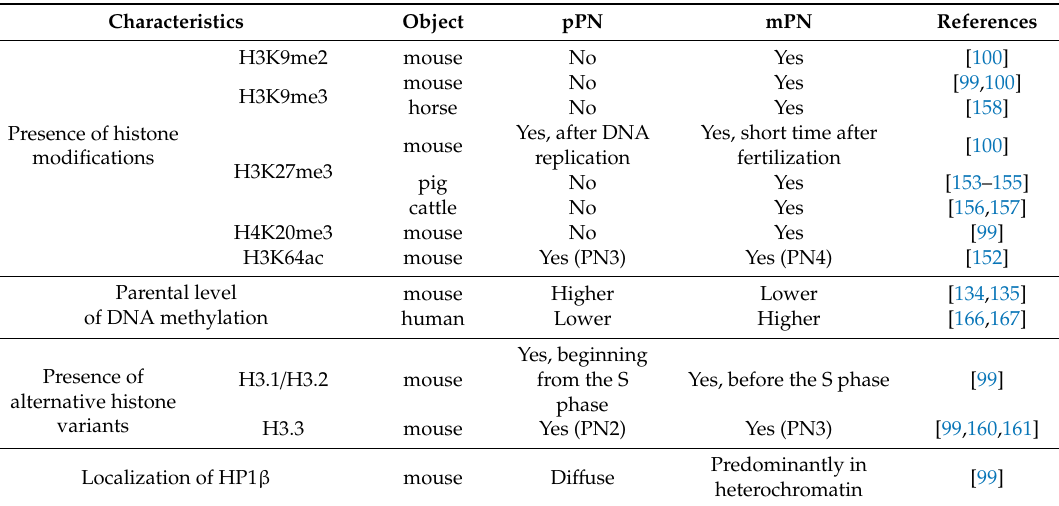
Table 3. Pronuclear asymmetry in mammalian